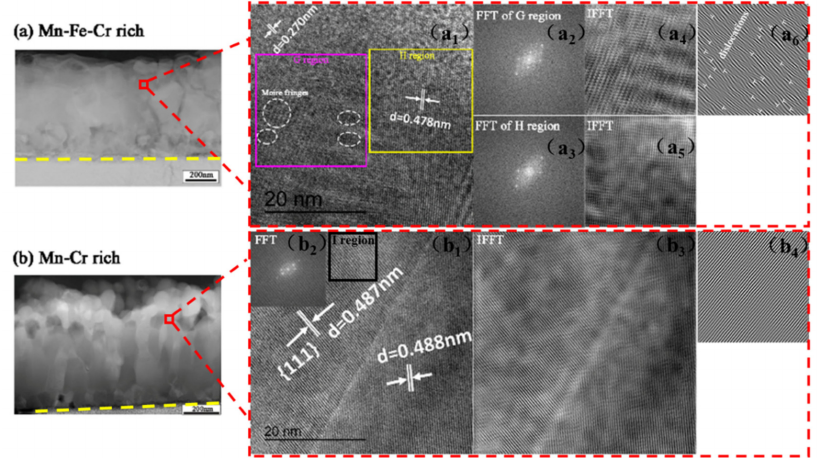
Figure 9. ( a ) HAADF images of the oxide layer of ST3 sample; ( a 1 ) HRTEM images of a selected region in ( a ); ( a 2 , a 3 ) Fast Fourier transform (FFT) images of G and H regions in ( a 1 ); ( a 4 , a 5 ) Inverse Fast Fourier transform (IFFT) images of G and H regions (filter); ( a 6 ) IFFT image of G region; ( b ) HAADF image of oxide layer of HT3 sample; ( b 1 ) HRTEM image of selected region in ( b ); ( b 2 ) FFT image of ( b 1 , b 3 ); IFFT image of ( b 1 ) (filter); ( b 4 ) IFFT image of I region in ( b 1